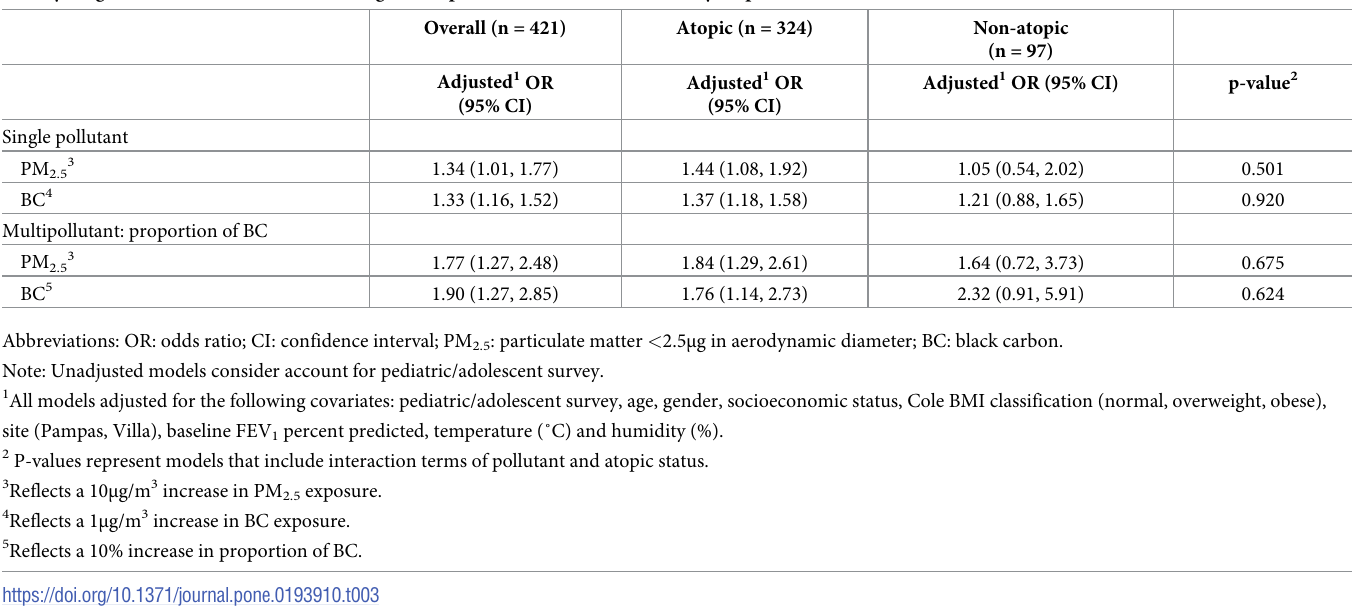
Table 3. Adjusted 1 single and multipollutant logistic regression analyses evaluating the association of PM 2.5 and black carbon with rhinoconjunctivitis quality of life in young children and adolescents residing in Pampas and Villa, Peru, stratified by atopic